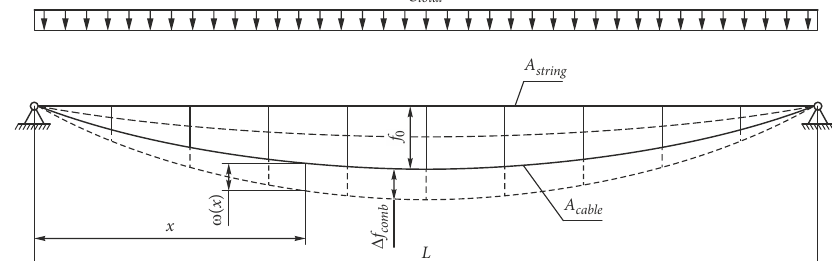
Figure 2. Combined string structure scheme